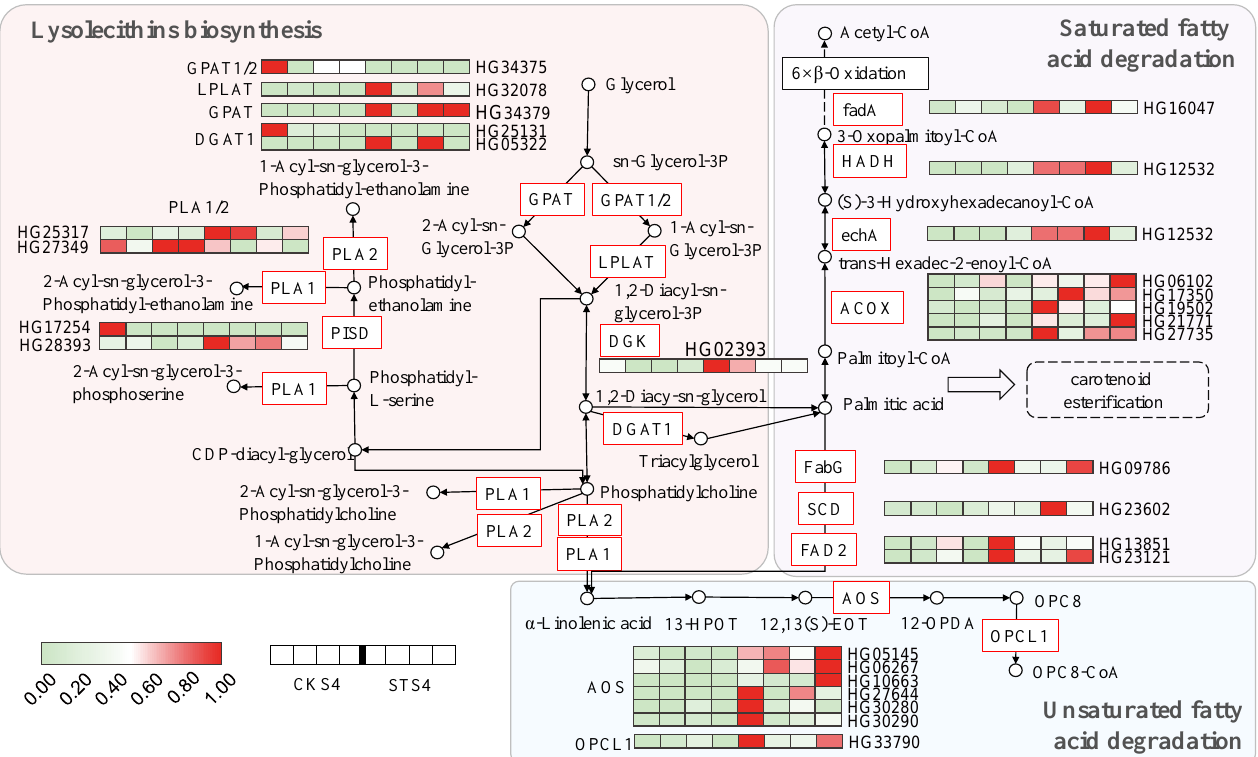
Figure 4. Differentially expressed genes (DEGs) and accumulated metabolites (DAMs) related to lipid metabolism. Rectangle and circle cells indicate the DEG and DAM, respectively. The color key indicates that the transcript levels from low to high are represented from light green to red. CKS4 and STS4 are S4 fruits without and with 300 mM of salt stress treatment. GPAT, glycerol-3-phosphate acyltransferase; LPLAT, lysophospholipid acyltransferase; DGK, diacylglycerol kinase; DGAT1, diacylglycerol O-acyltransferase 1; PLA1/2, phosphatidylserine sn-1/2 acylhydrolase; PISD, phosphatidylserine decarboxylase; FAD2, omega-6 fatty acid desaturase; SCD, stearoyl-CoA desaturase; FabG, 3-oxoacyl-[acyl-carrier protein] reductase; ACOX, acyl-CoA oxidase; echA, enoyl-CoA hydratase; HADH, 3-hydroxyacyl-CoA dehydrogenase; fadA, acetyl-CoA acyltransferase; AOS, hydroperoxide dehydratase; OPCL1, OPC-8:0 CoA ligase 1.